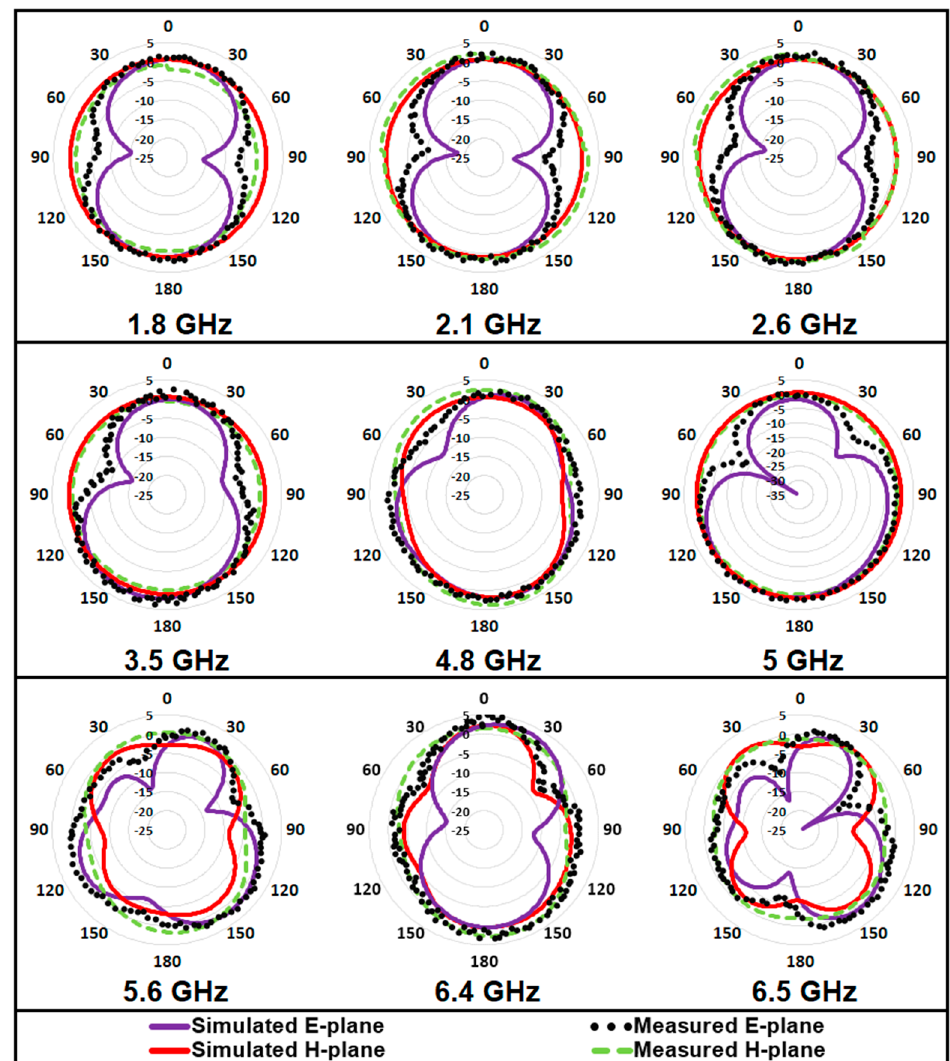
Figure 9. Comparison of simulated and measured radiation pattern in both principal planes.